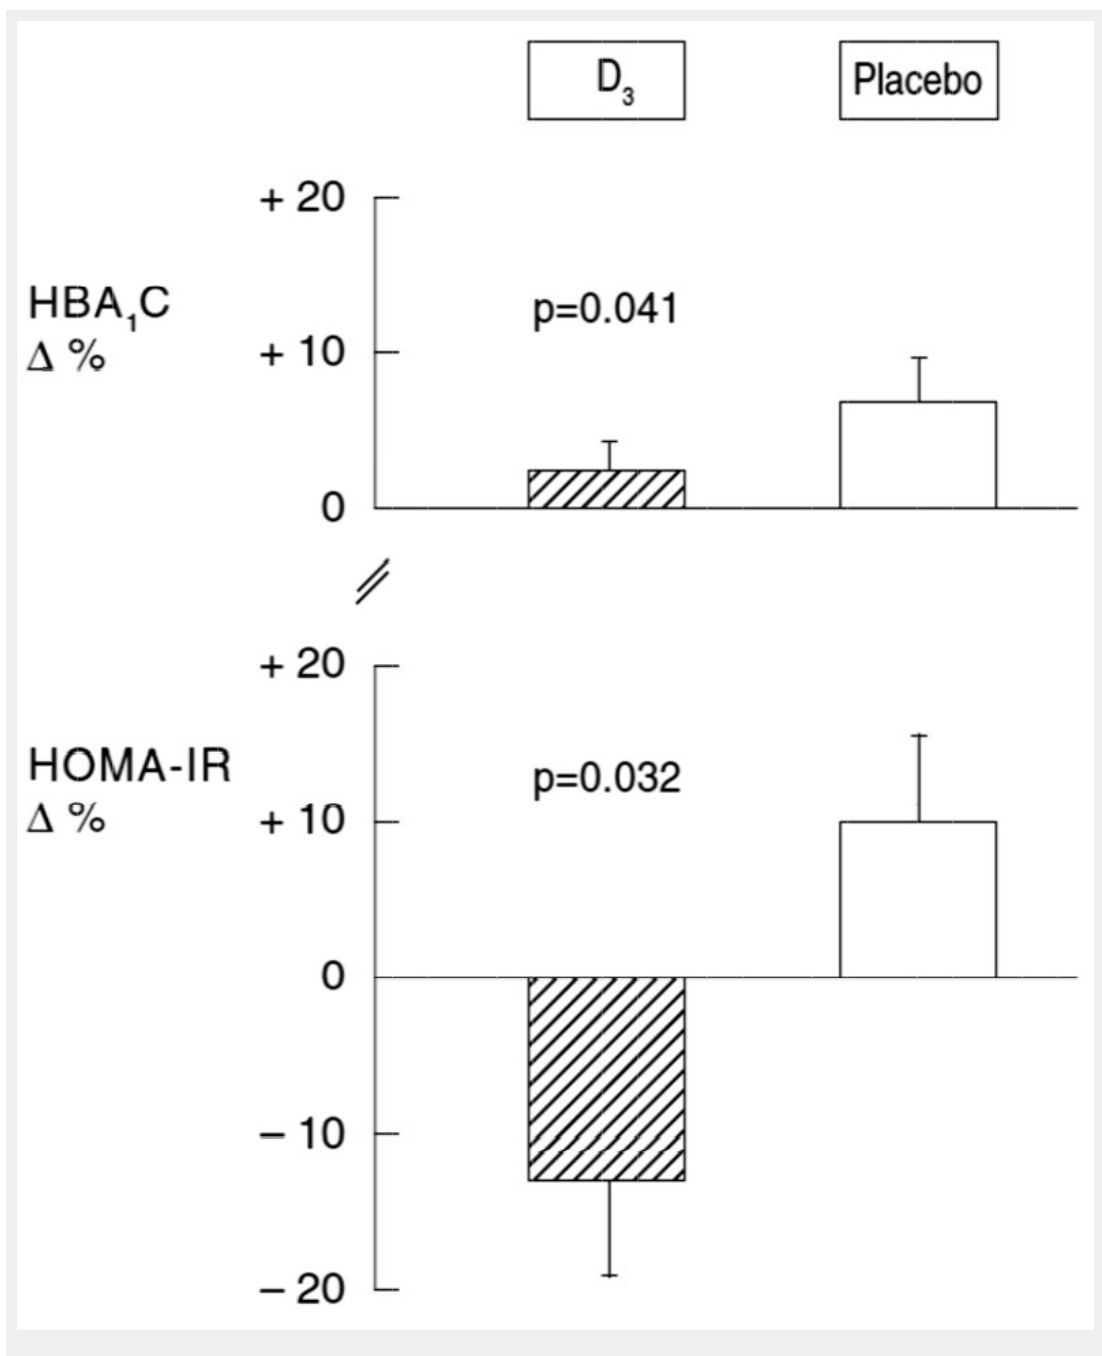
Figure 2 Effect of D 3 supplementation on the percent changes in HbA 1c and HOMA-IR. HbA 1c = glycosylated haemoglobin; HOMA-IR = homeostasis model assessment insulin